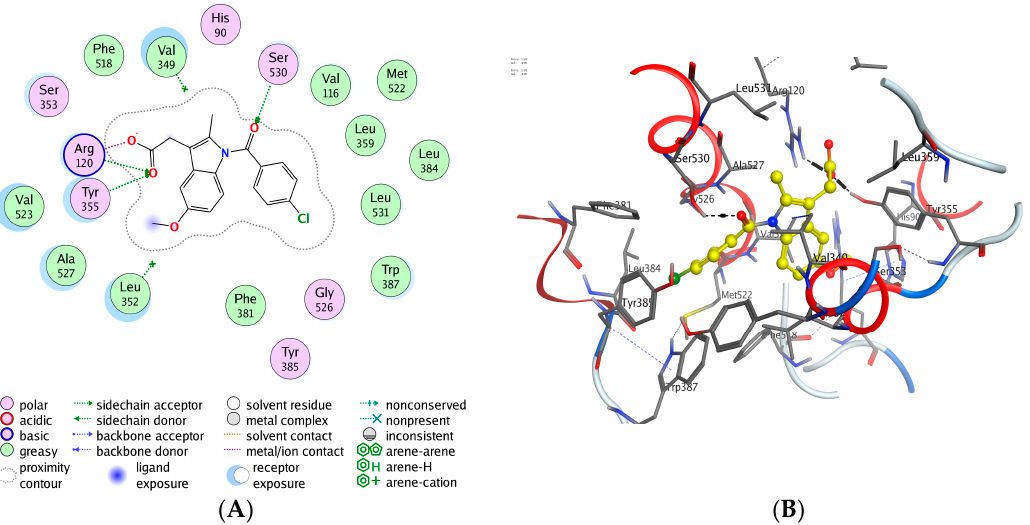
Figure 6. Reference compound indomethacin in the binding site of COX-2 (PDB: 4COX). ( A , B ) represents the 2D and 3D docking view of indomethacin binding site of COX-2. In 2D, green dashed line represents hydrogen bonding; green dashed line represents pi-H bonding; residues which are colored light green, represents hydrophobic interactions. In 3D, black dashed line represents hydrogen bonding; blue dashed line represents pi-H bonding.